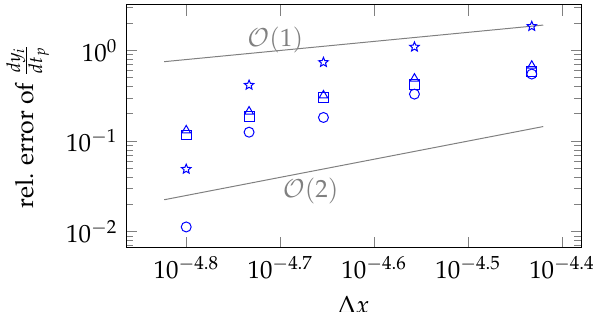
Figure 5. Grid independency study (sensitivities). Relative errors of sensitivity of y 1 = (cid:107) u ( x ,4 ) (cid:107) ( ), y 2 = (cid:107) ϕ ( x ,4 ) (cid:107) ( ), E ( ϕ ) ( ), σ 2 ( ϕ ) ( ) with regard to t p at t p = 0.6 and the finest L 2 ( Γ out ) resolved